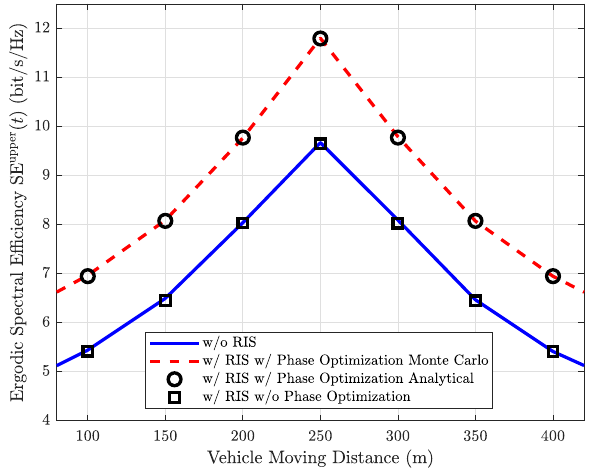
Figure 3. Ergodic SE for one vehicle pass with the distance-dependent Rician